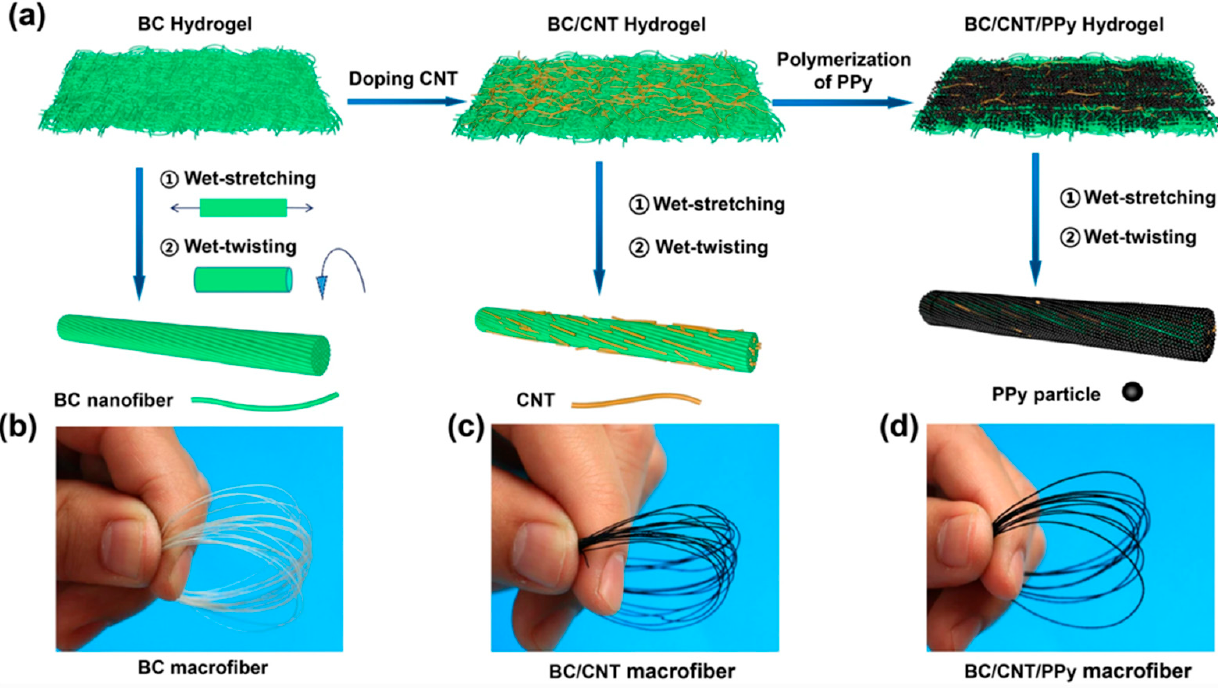
Figure 4. ( a ) Schematic view of the fabrication process of BC, BC/CNT/PPy macrofibers used in the fabric-based TENG developed by Hu et al. [155]. Images of ( b ) BC macrofibers, ( c ) BC/CNT macrofibers, and ( d ) BC/CNT/PPy macrofibers. Reprinted with permission from [155]. Copyright ©2022, Springer Nature.